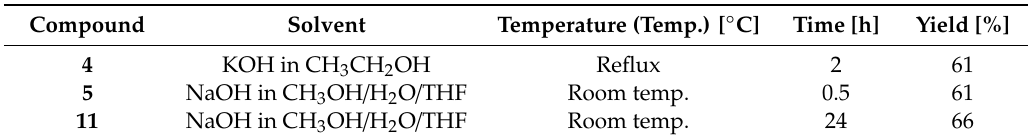
Table 1. A comparison of the alkaline hydrolysis reaction conditions leading to the formation of phosphonate compounds 4 , 5 and 11 .